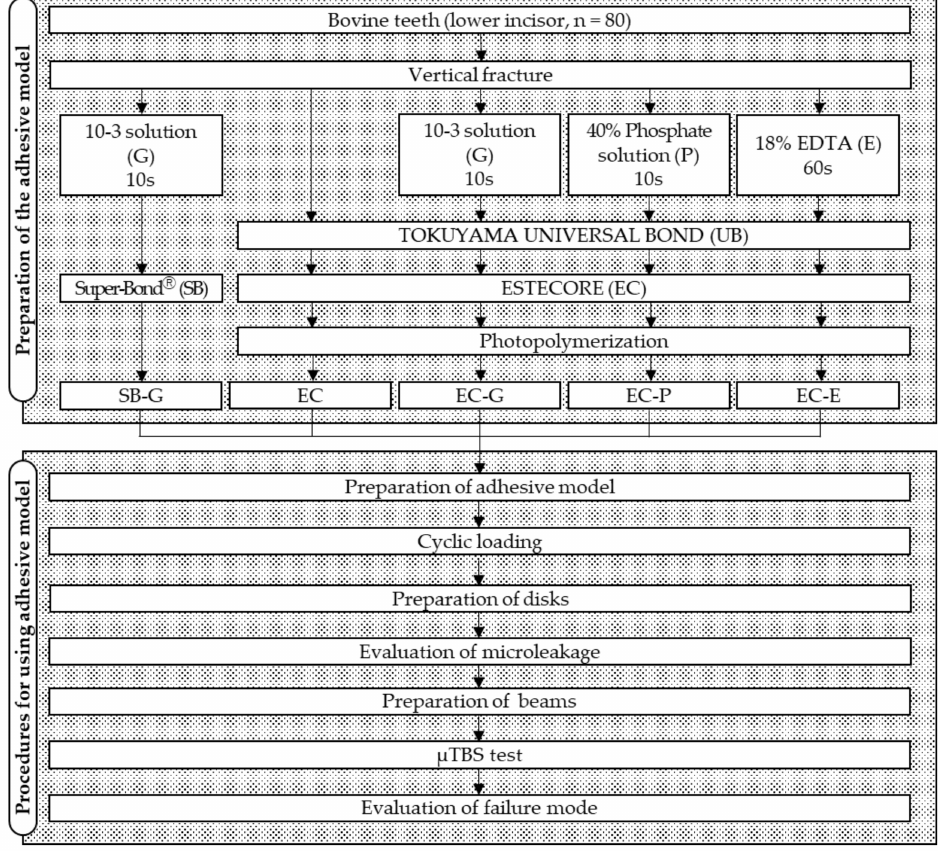
Figure 1. Flowchart of the experimental procedure. 10-3 solution, 10% citric acid with 3% ferric chloride solution; EDTA, ethylenediaminetetraacetic acid; µ TBS, microtensile bond